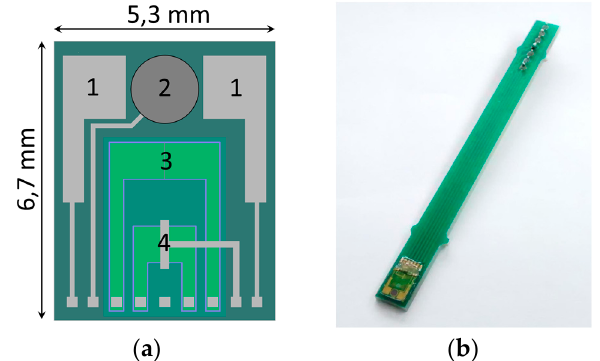
Figure 1. ( a ) Schematic top view of the microsystem. (1) Platinum electrodes for EC measurements; (2) Miniature Ag/AgCl quasi-reference electrode; (3) ISFET micro-sensor; (4) MOSFET for temperature measurement; ( b ) View of the chip after electronic packaging on a printed-circuit board (PCB) and